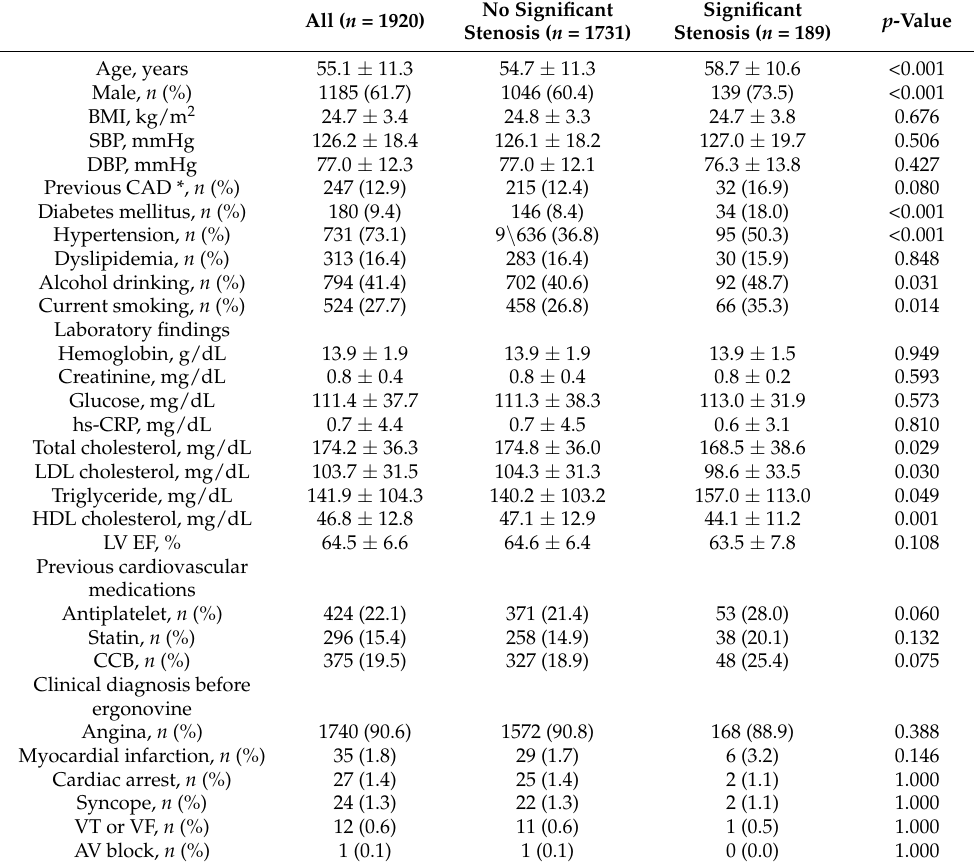
Table 1. Baseline